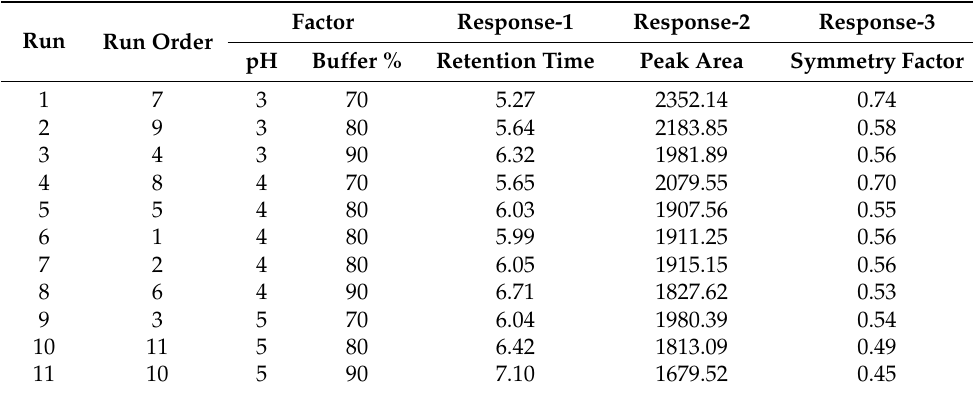
Table 2. Design matrix as per the CCD for optimization of parameters for analysis of M-HCl. Factor Response-1 Response-2 Response-3 Run Run Order pH Buffer % Retention Time Peak Area Symmetry